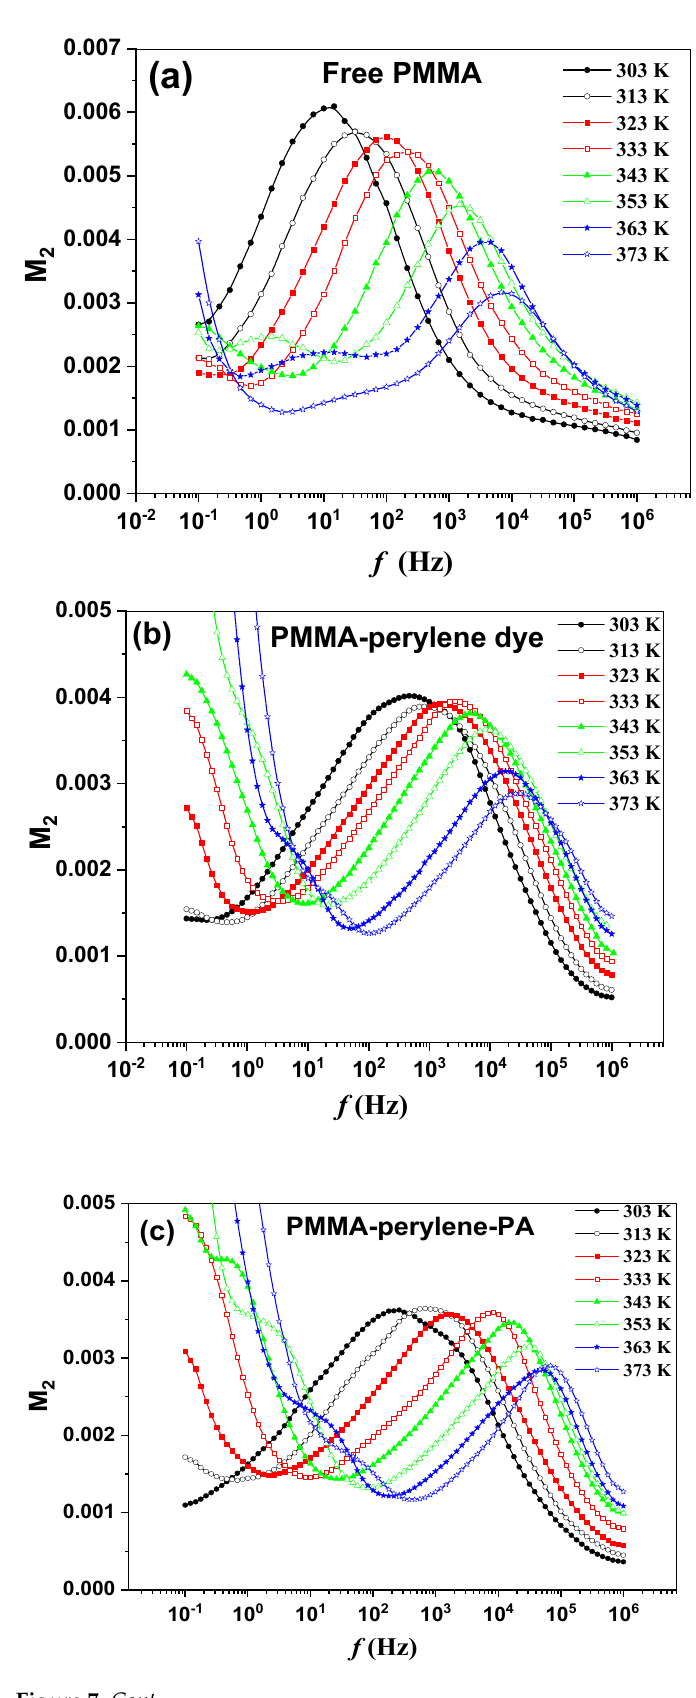
f (Hz) Figure 6. ( a – e ): The frequency dependence of the tan δ of the synthesized polymeric sheets. Another representation of the complex relative permittivity ( 𝜀 ∗ ) is the complex elec- tric modulus ( 𝑀 ∗ ). The 𝑀 ∗ formalism gives a clearer characterization of the dipolar relax- ation mechanisms of the synthesized polymeric sheets. The 𝑀 ∗ formalism is described by the following relation [25]. 𝑀 ∗ = 1